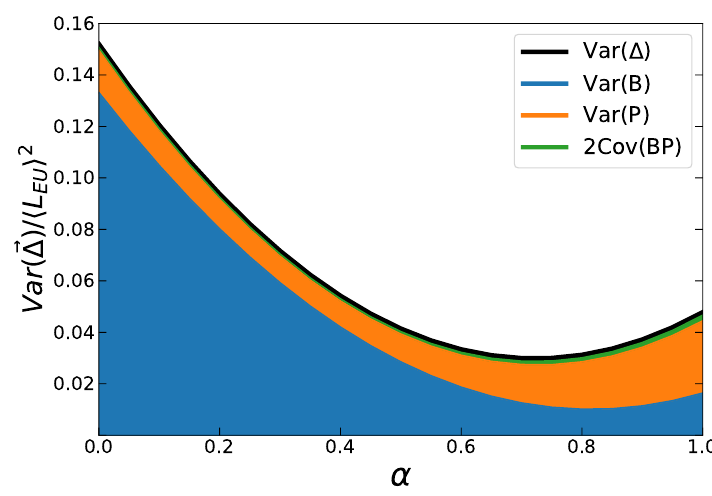
Figure 2. Mismatch variance Var ( (cid:126) ∆ ) (thick black curve) as a function of the renewable mix α for the renewable penetration γ = 1. The solar share increases towards α = 0, and the wind share increases towards α = 1. The coloured parts illustrate its decomposition (9) into the variances of the balancing (blue) and the injection (orange) as well as their covariance (green).